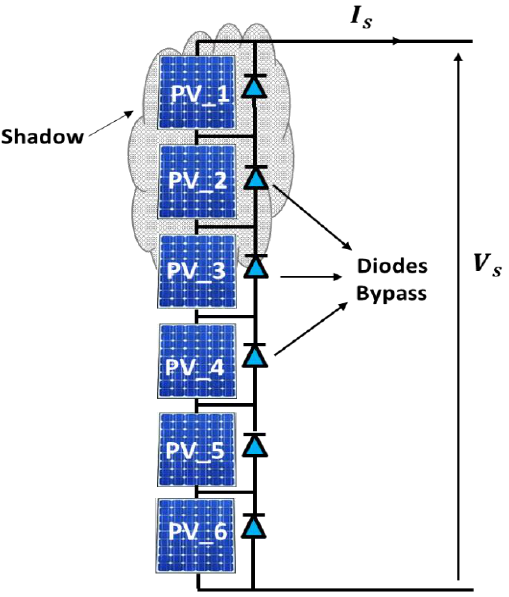
Figure 4. PV array with three PV panels exposed to